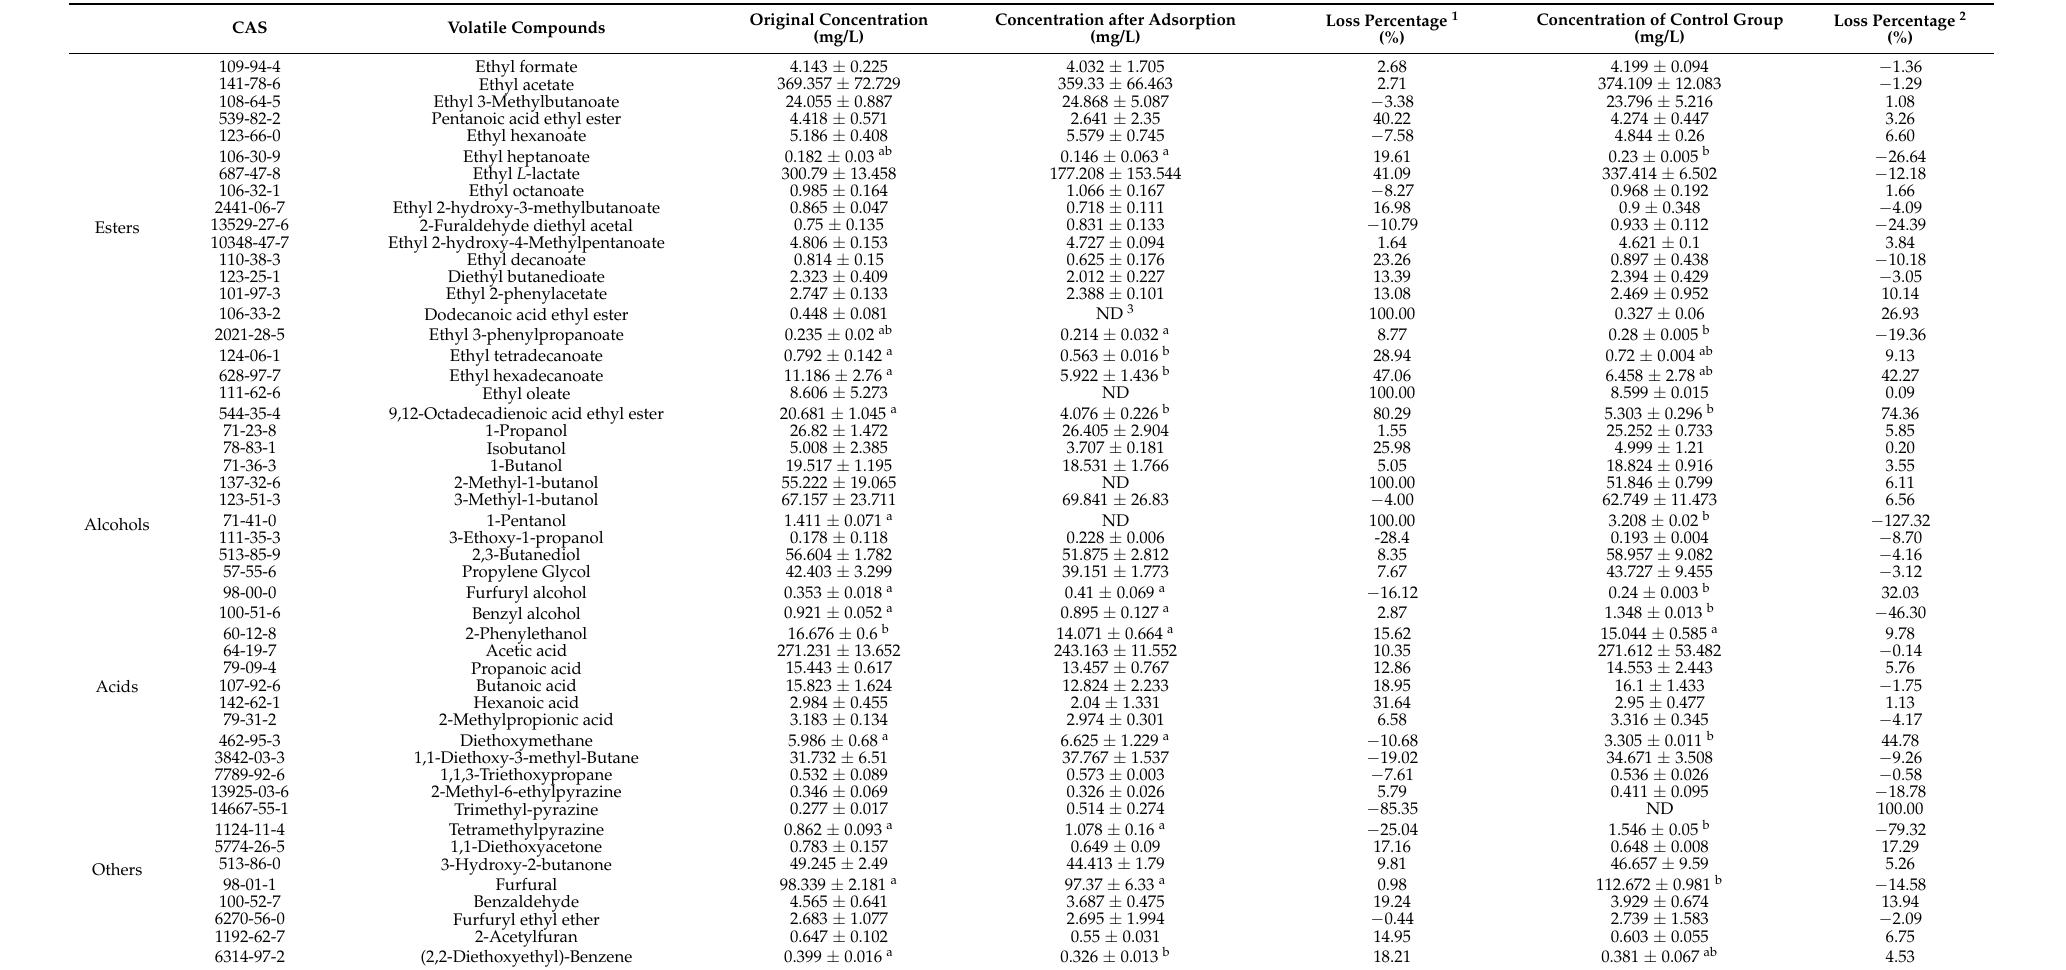
Table 1. Changes in volatile compounds before and after Baijiu I